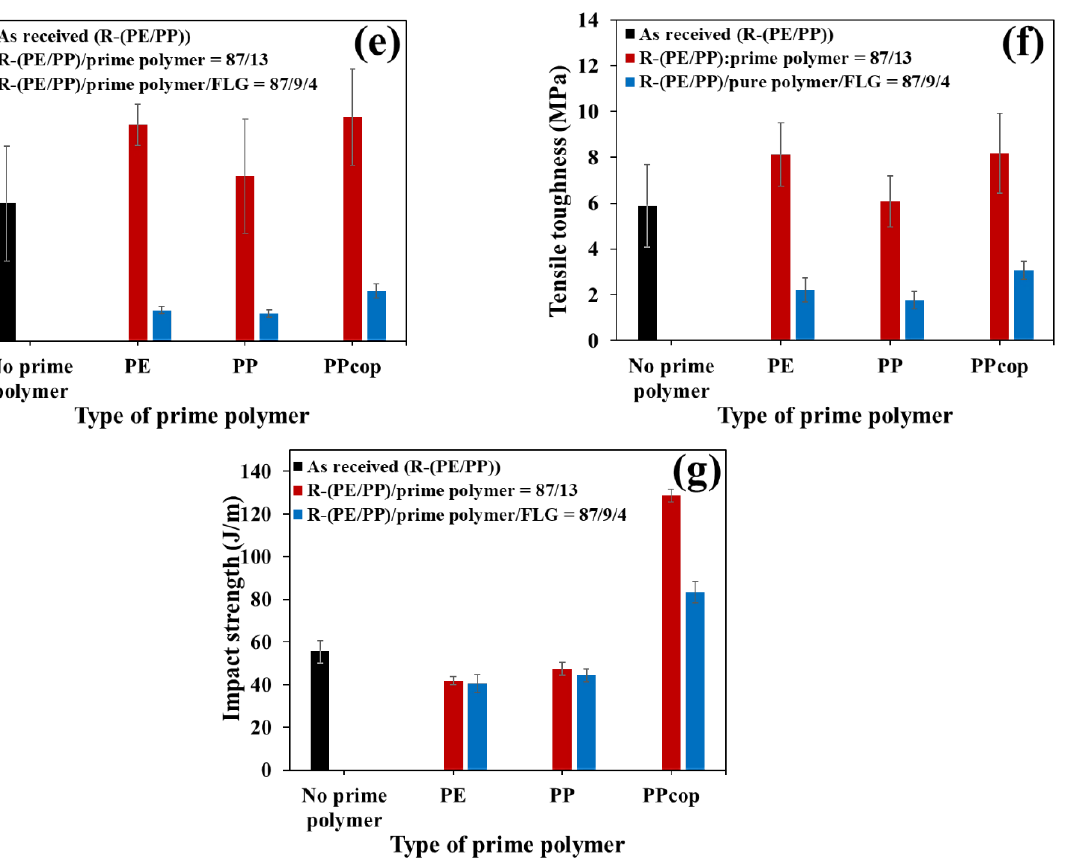
Figure 3. ( a ) Tensile strength, ( b ) flexural strength, ( c ) tensile modulus, ( d ) flexural modulus, ( e ) elongation at break, ( f ) tensile toughness, and ( g ) impact strength of the Type 2 and Type 3 samples as a function of the type of the used prime polymer. The properties of the as received R-(PE/PP) are presented by the black bars as a baseline.